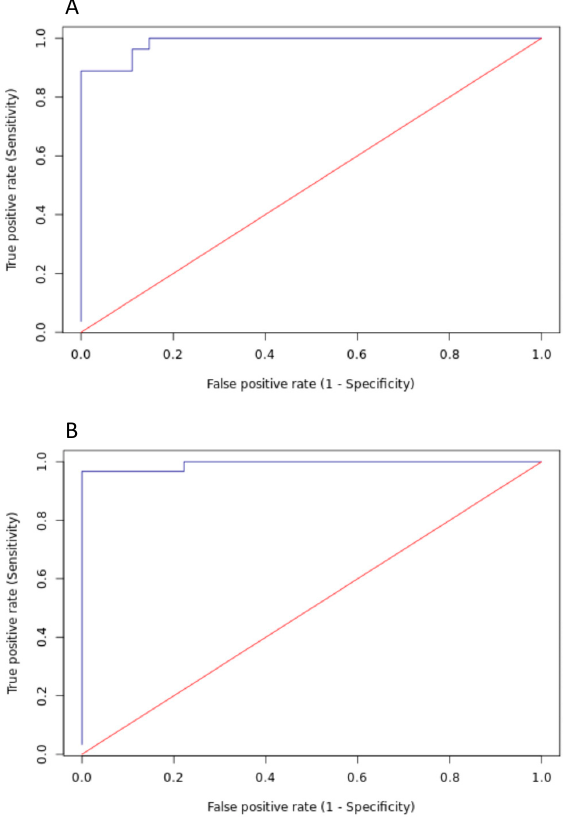
Figure 1. Receiver operating characteristic (ROC) curves of the diagnostic accuracy of MilkoScan FT-plus to detect colostrum of good quality for bovine (( A ); IgG ≥ 50 g/L) and for ovine (( B ); IgG ≥ 20 g/L). The values for the area under the curve (AUC) are 0.986 and 0.993, respectively, for bovine and ovine